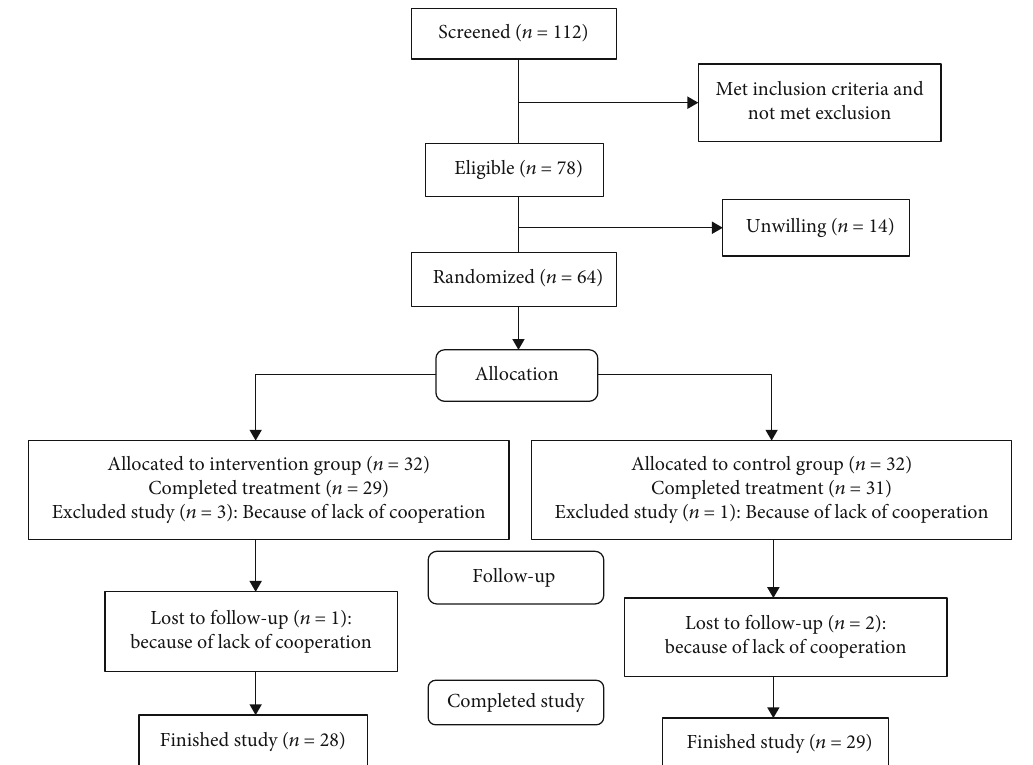
Figure 1: Flow chart illustrating the progress of patients through the study. Table 1: Baseline characteristics and FD-related summary measures of randomized patients. Baseline